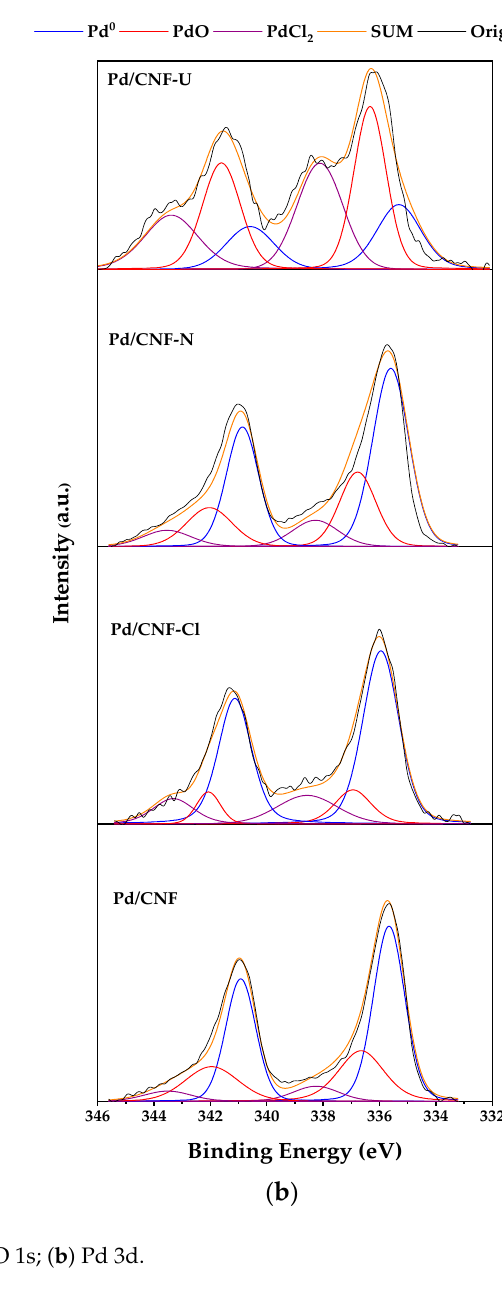
Figure 2. XRD patterns of the catalysts (I: C(002); II: Pd(111); III: C(100); IV: C(101); V: C(004); VI: C(110)).